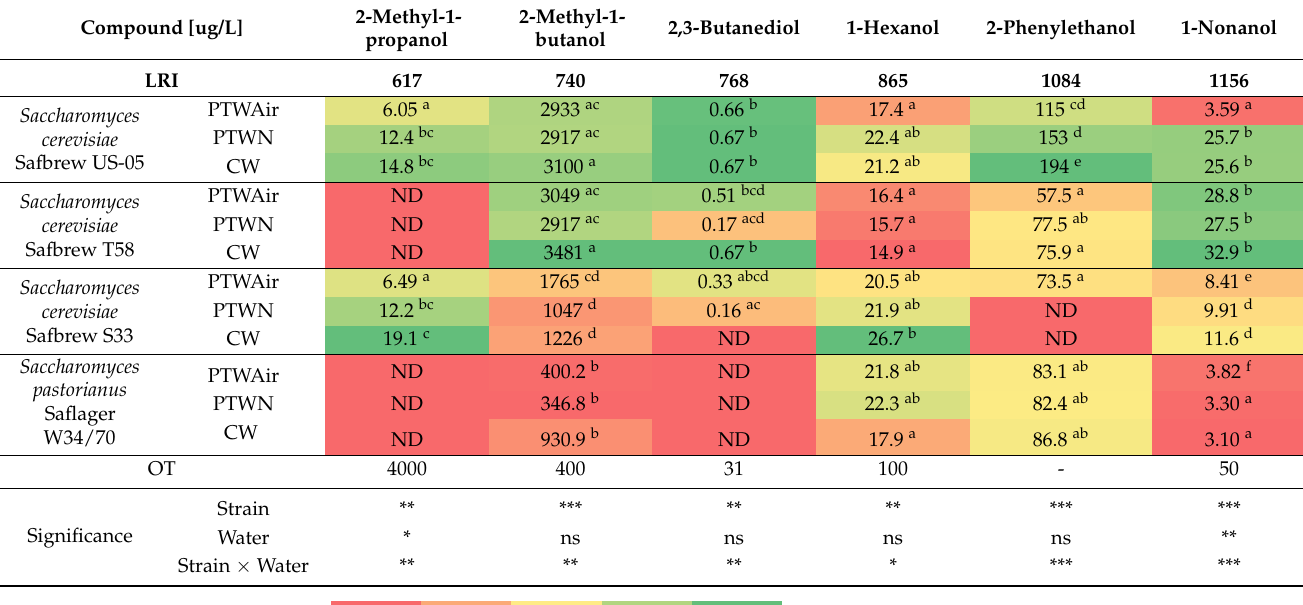
Table 5. Higher alcohol in beers fermented by Saccharomyces cerevisiae (T58, US-05, S33) and Saccha- romyces pastorianus (W34/70) after rehydration with PTWAir, PTWN and control water (CW).